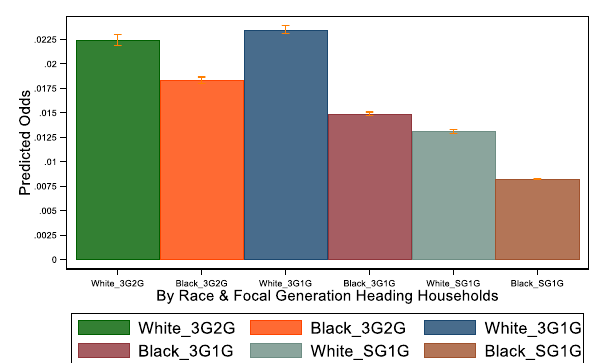
Fig. 1 Odds of breakups in three intergenerational households. Source : SPP 2004, 2008, and 2014 Paneis. Notes : Odds averaged over months; 95% con fi dence intervals indicating margins of error for